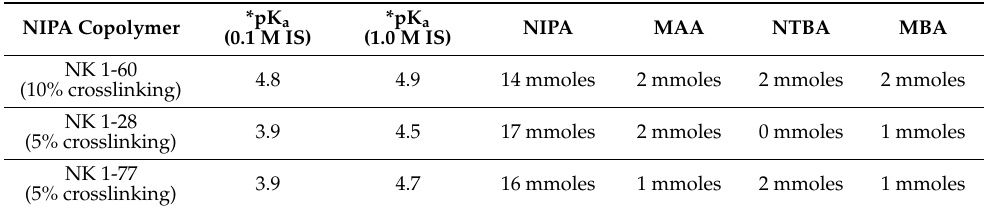
Figure 2. pH Response of NK 1-60 at room temperature and 37 °C for ascending and descending pH. Table 1. Crosslinking